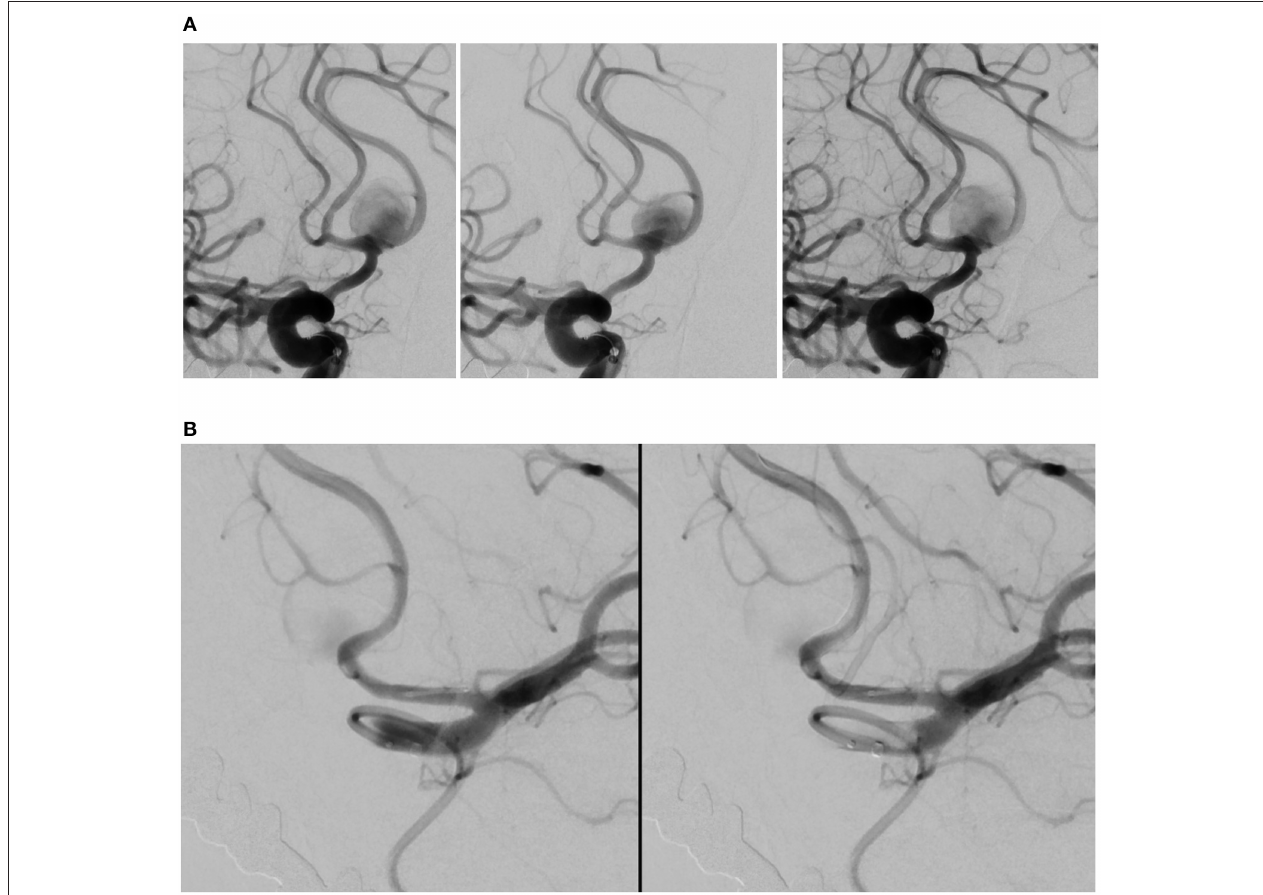
FIGURE 1 | Angiography deployment of SVB stents using kissing technique (stent diameter: 2.75mm, length: 20mm). (A) Right ICA contrast media (CM) injection following SVB implantation using kissing technique. Opacification of the A2 segment indicates blood flow diversion from the A1 segment into A2 segment, later confirmed by the aneurysm sac filling with CM. (B) Left ICA CM in the same patient. The aneurysm sac is less opacified by the CM, where blood flow diversion is immediately